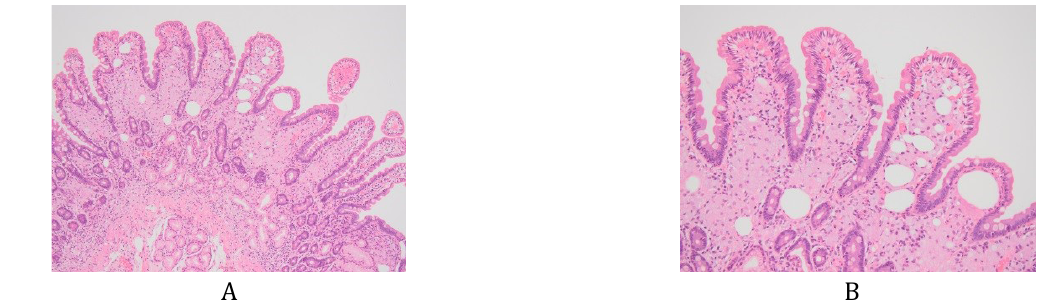
Figure 5. Hematoxylin and eosin (HE) stains of the duodenal biopsy showing multiple foamy histiocytes in the axis of the villi. A: HE, ×100; B: HE, ×200